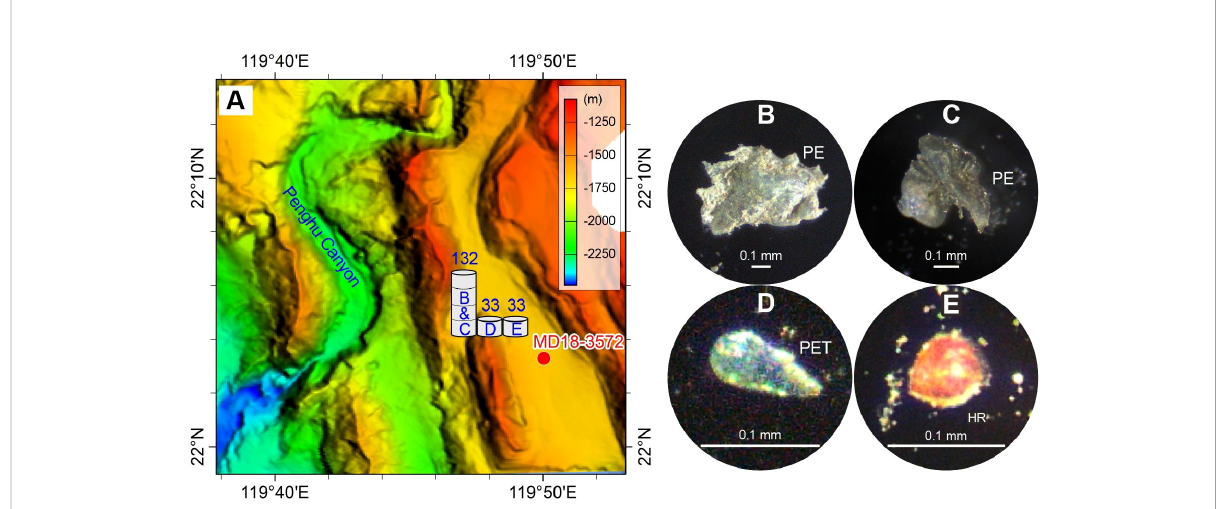
Figure 1 for the location of sample MD18-3572 and related Penghu Canyon.